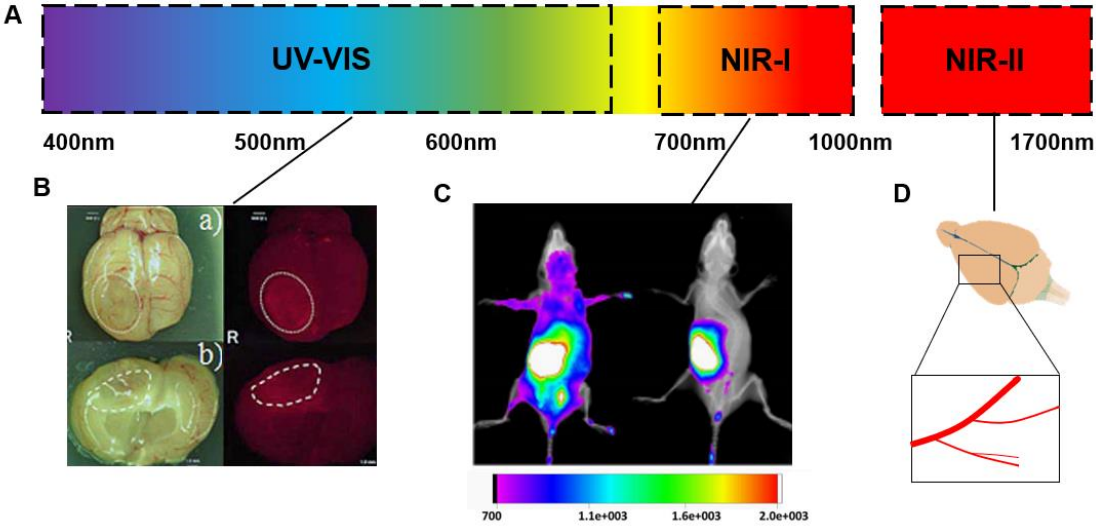
Figure 2. Optical imaging of brain tissue in visible light, NIR-I and NIR-II wavelengths. ( A ) Schematic diagram of visible-light, NIR-I and NIR-II wavelength intervals. ( B ) Macroscopic view of (a) whole brain and (b) coronal images after administration of 5-aminolevulinic acid (5-ALA) in a rat vasogenic edema model, as well as fluorescence images obtained using a 610 nm long path filter. Reprinted with permission from Ref. [6]. © 2009, TakaoTsurubuchi. ( C ) The in vivo biodistribution assay of NANG/PLGA/DTX/ICG NPs was analyzed in terms of fluorescence intensity (the fluorescence intensity scale below ranges from cold to warm colors indicating low to high intensity, and e +003 denotes 10 to the third power). Extensive retention of targeted nanoparticles in brain regions was observed. Reprinted/adapted with permission from Ref. [18]. © 2015, Yongwei Hao. ( D ) NIR-II fluorescence through skull microscopic imaging using a 1100 nm long path filter was used to monitor cerebral vascular changes in the same region of the mouse brain before and after the MCAO model to verify model success